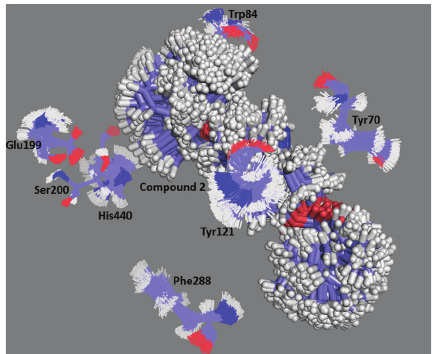
Figure 6: Frames of compound 2 inside